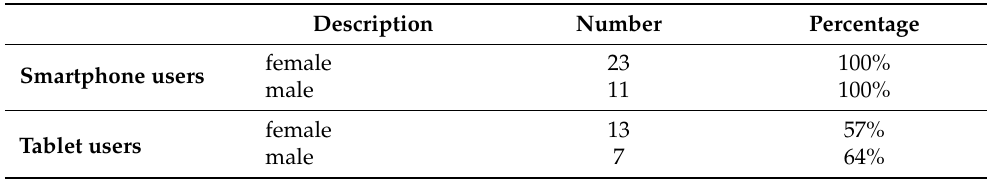
Table 3. Smartphone and tablet usage ( n = 34).